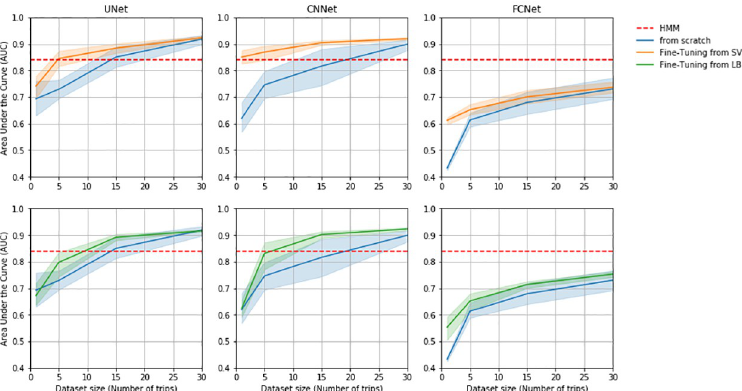
Fig 7. Fine-tuning. AUC indices of trained deep network function of dataset